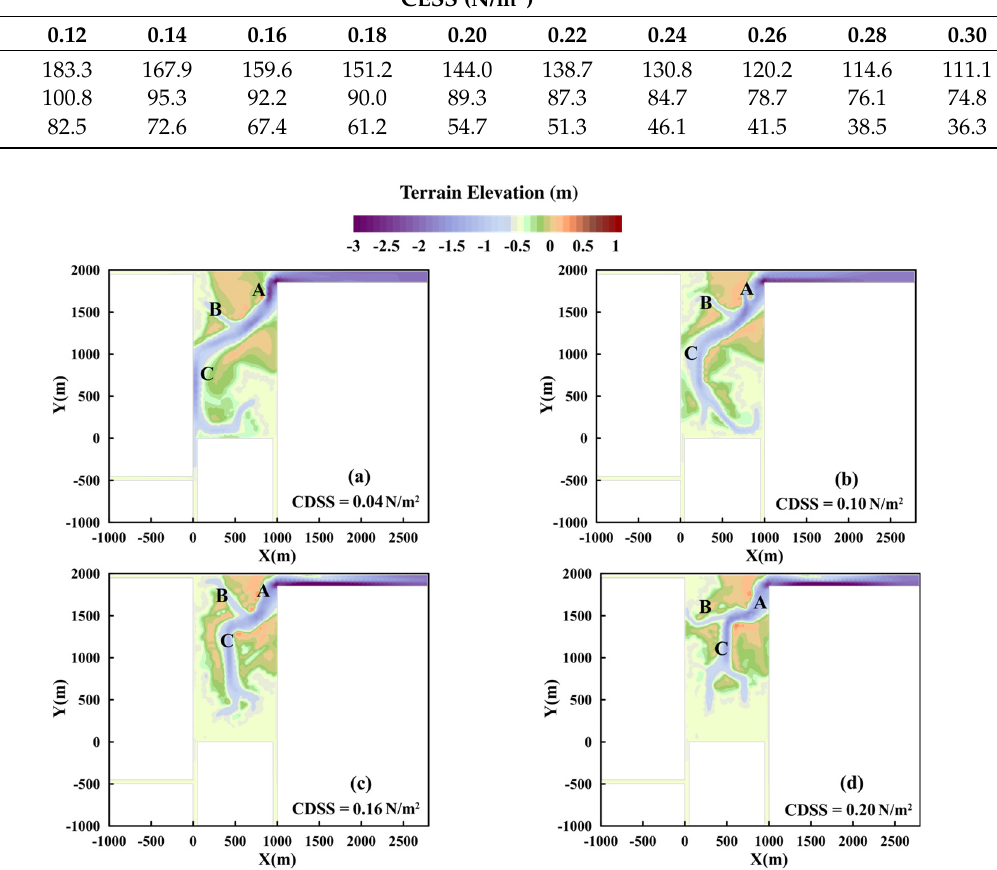
Figure 9. Terrain patterns of the ideal model of Qilihai Lagoon system under different CDSSs, after 100 years, where the CDSS is ( a ) 0.04 N/m 2 , ( b ) 0.10 N/m 2 , ( c ) 0.16 N/m 2 and ( d ) 0.20 N/m 2 . Erosion amount (EA), deposition amount (DA), and net erosion amount (NEA) per unit area for different CDSS after 100 years are shown in Table 2. According to Equation (4), with higher CDSS, the deposition amount should increase, but the EA and the DA is reduced in Table 2. Due to the increase of CDSS from the minimum to the maximum values, the variations of EA and DA were 30.6 kg/m 2 and 17.2 kg/m 2 , respectively. On one hand, with the intensive deposition effect, the erosion effect was limited as a result, so that the sediment could not be suspended from the bed erosion. On the other hand, with less suspended sediment, the DA was reduced. Consequently, even though the NEA decreased due to higher CDSS, the lagoon system still suffered